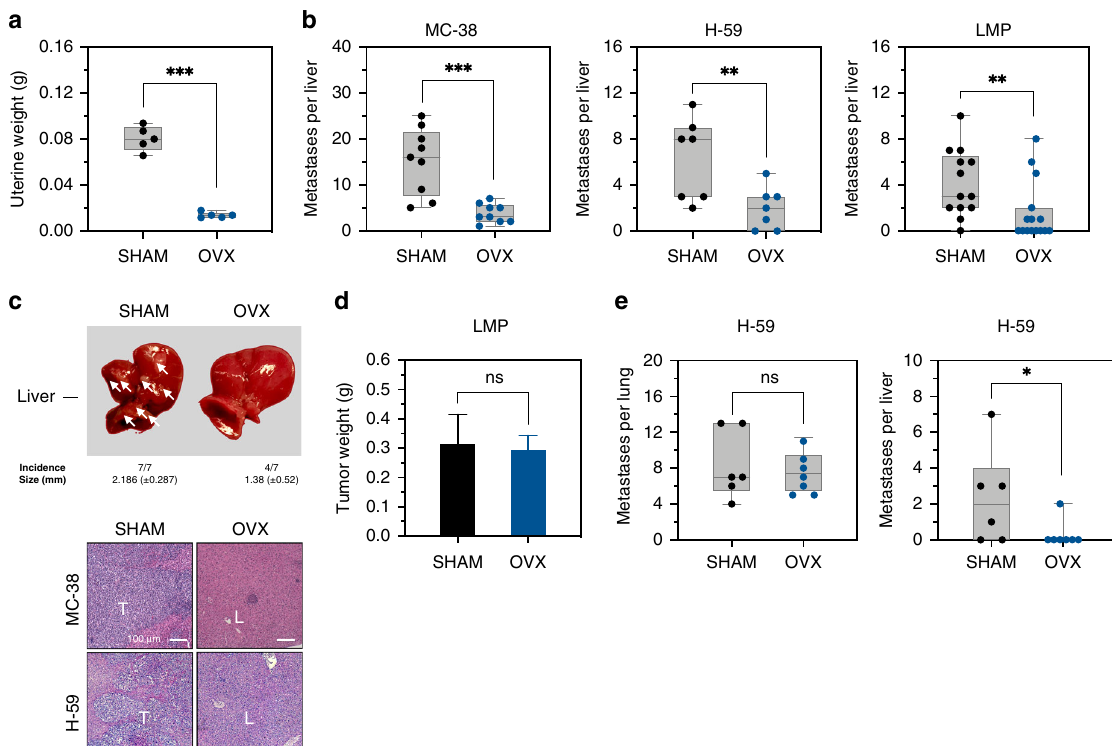
Fig. 3 Ovariectomy reduces LM in a site-speci fi c manner. Experimental LM were generated by inoculation of 2 × 10 5 colon carcinoma MC-38 or lung carcinoma H-59 cells via the intrasplenic/portal route, spontaneous LM of PDAC were generated by intrapancreatic injection of 1 × 10 6 Kras G12D/ + ;LSL- Trp53 R172H/ + ;Pdx-1-Cre (LMP) cells and experimental lung metastases by intravenous inoculation of 2 × 10 5 H-59 cells. Mice were sacri fi ced and metastases enumerated 15 – 30 days later. Shown in a are the uterine weights (means ± s.e.m.) as measured 3 weeks post ovariectomy or sham surgery. Shown in b are the numbers of visible metastases counted per liver of individual mice inoculated with the indicated tumor cells ( n = 10 for MC-38 injected; n = 7 for H59 injected; and n = 14 for LMP-injected mice). Representative livers (top) and H&E stained liver sections (bottom) from MC-38- inoculated mice are shown in c and pancreatic tumor weights of LMP-injected mice (mean ± s.e.m., n = 14) are shown in d . Shown in e are the numbers of experimental lung (left) and liver (right) metastases counted 15 days following a tail vein injection of 2 × 10 5 H-59 cells (left panel: n = 5 for sham and n = 7 for OVX mice, right panel, n = 6 for sham and n = 7 for OVX mice). Horizontal bars denote median values. * − p ≤ 0.05; ** − p ≤ 0.01; *** − p ≤ 0.001; **** − p ≤ 0.0001; NS, not signi fi cant as determined by the Mann – Whitney test (metastases) or Student's t -test (organ weights). Box and whiskers graphs: the box extends from the 25th to 75th percentiles, the middle line denotes the median and the whiskers extends from the minimum to the maximum value. Scale bars correspond to 100 µ m on IF